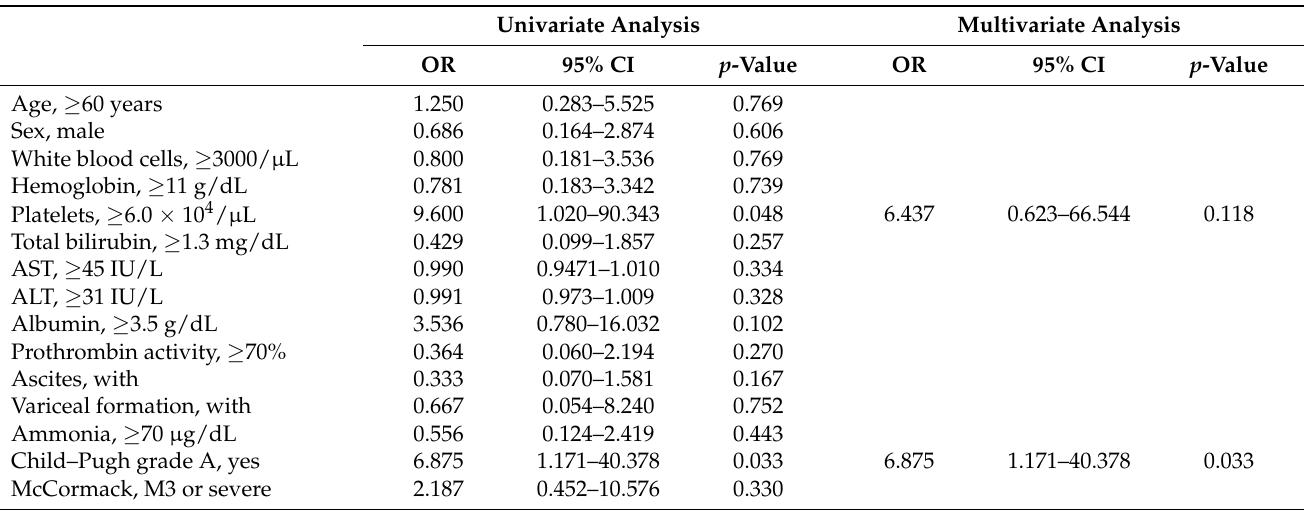
Table 3. Univariate and multivariate logistic regression analyses of baseline factors related to the improvement of portal hypertensive gastropathy by partial splenic embolization. Univariate Analysis Multivariate Analysis OR 95% CI p